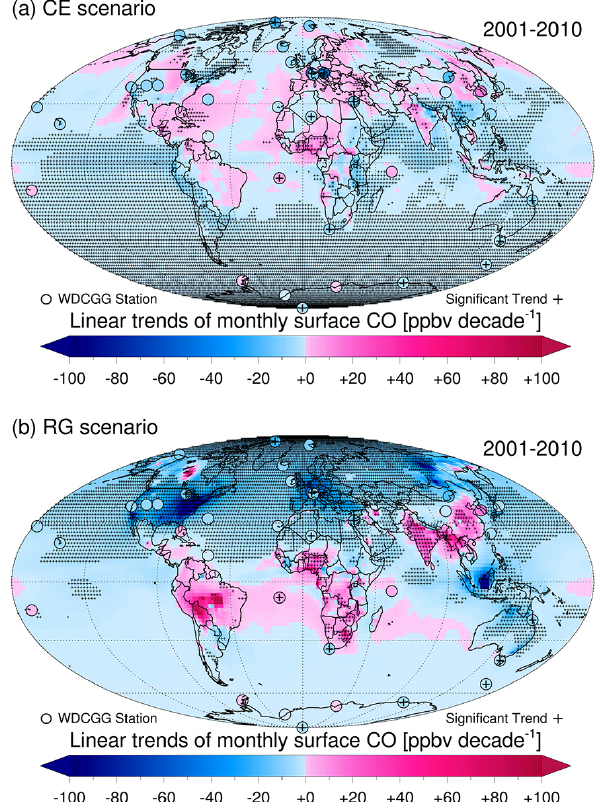
Figure 8. Global trend estimates of monthly WDCGG-archived and EMAC-simulated surface CO based on (a) CE and (b) RG scenar- ios from 2001 to 2010. The significant trends are shown as a plus symbol ( + )